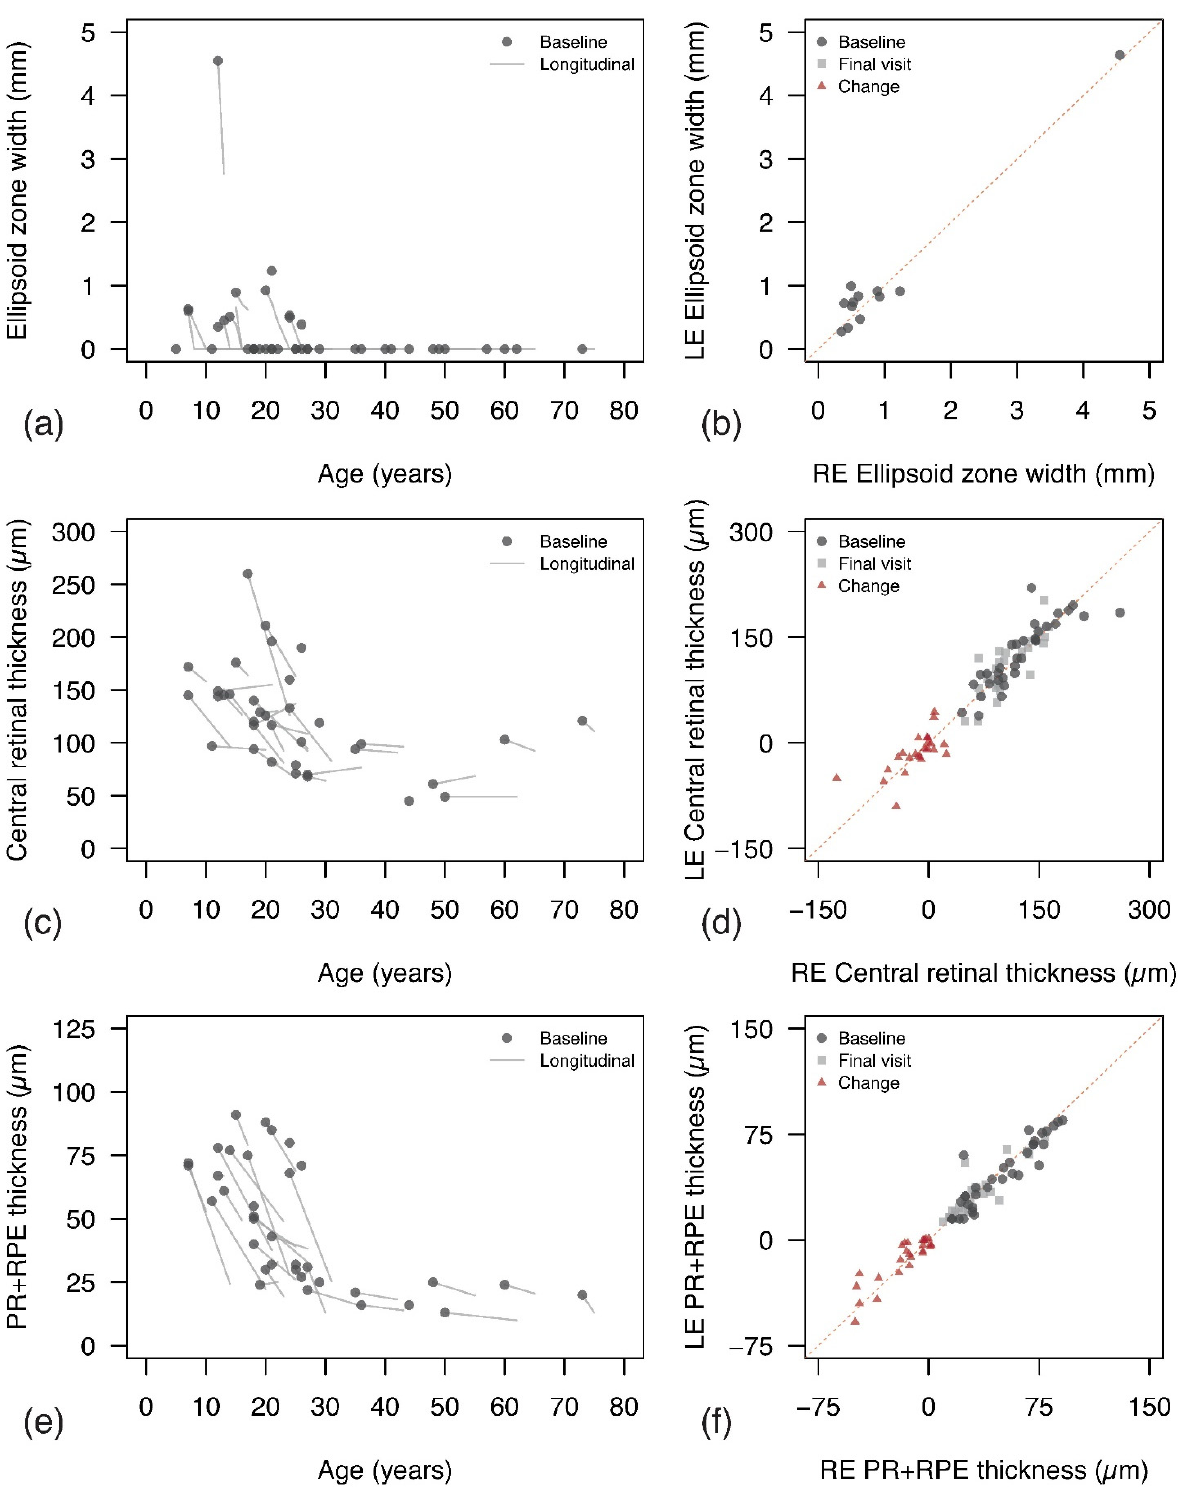
Figure 3. Changes in SD-OCT quantitative measures by age ( a , c , e ) and inter-ocular relationship ( b , d , f ) for ellipsoid zone (EZ) width, central retinal thickness (CRT), and photoreceptor and retinal pigment epithelium complex (PR+RPE) thickness. The findings are consistent with Figure 1, except for EZ width measures due to the limited data availability. ( a ) EZ widths at first visit from all pa- tients are reported as data points. For patients with a non-measurable EZ, a value of 0 µm was used for plotting purposes. EZ widths from follow-up visits were also reported by simple segments, ra- ther than best linear fit. ( b ) Inter-ocular relationship for EZ width at baseline. ( c ) CRTs at first visit